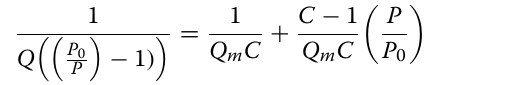
file 1: Table S2 of Supplementary Information section.